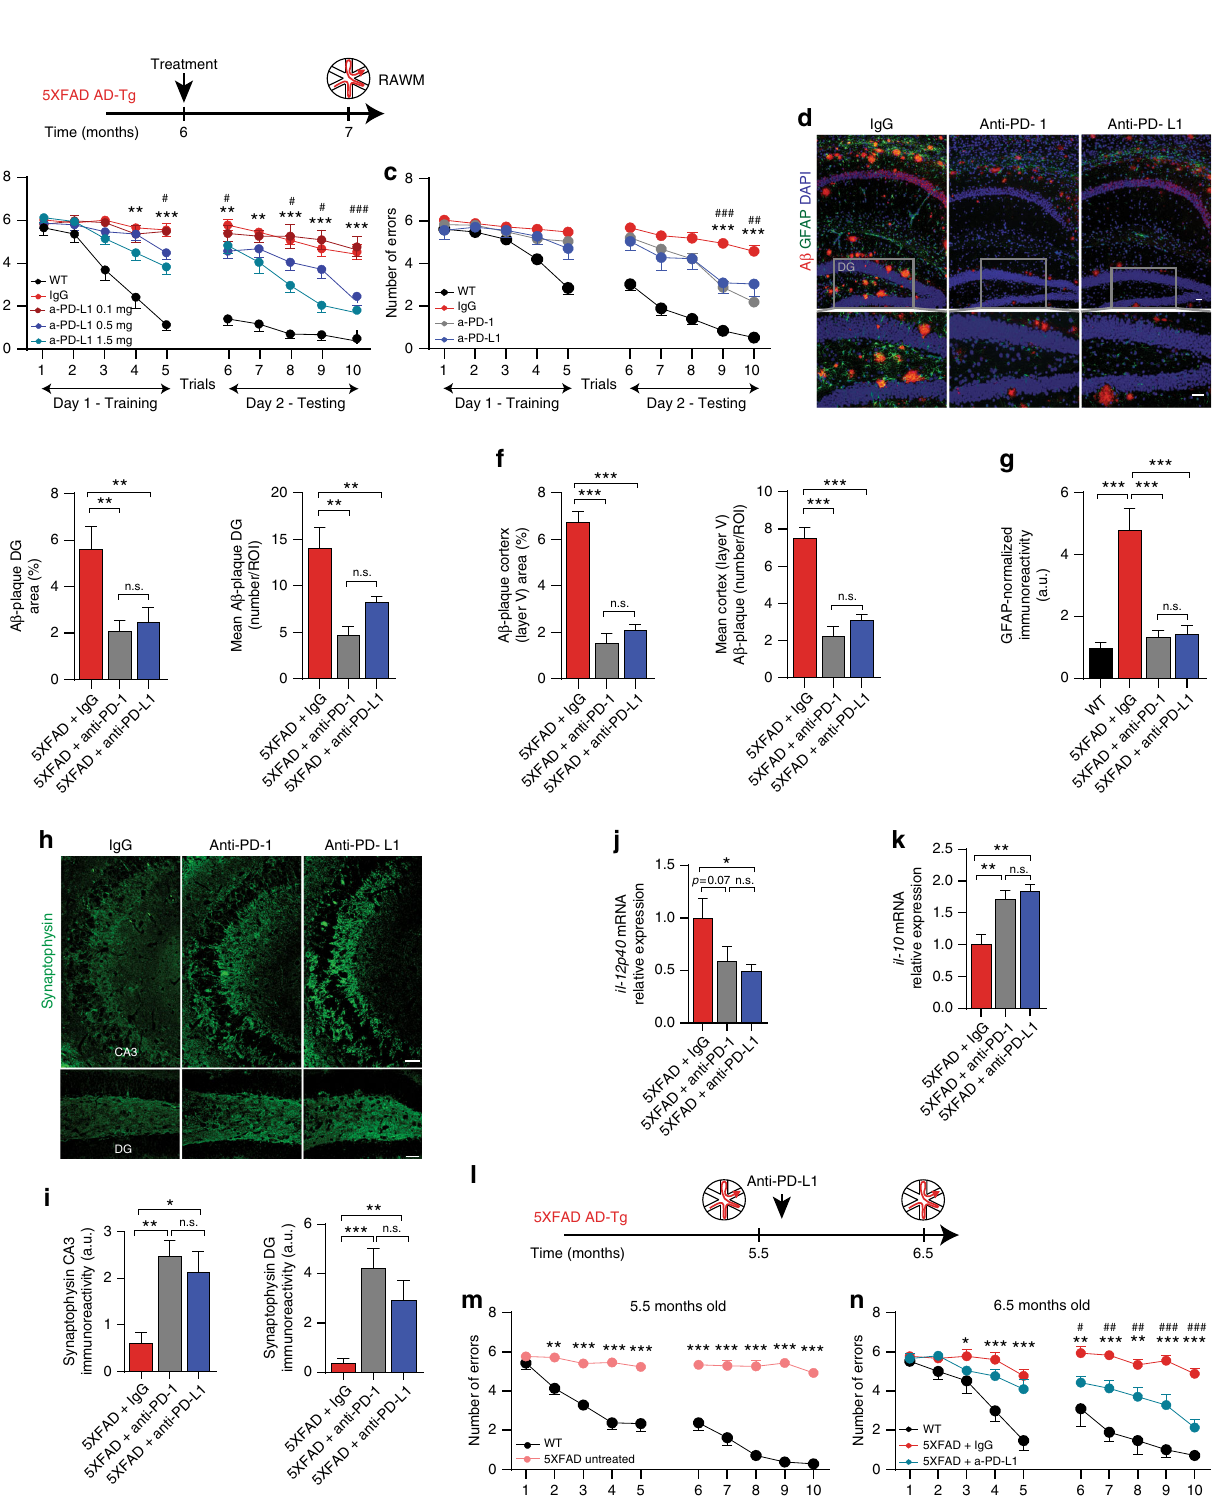
anti-PD-L1 antibody at a dose of 1.5 mg/mouse was slightly more effective than the 0.5 mg dose, but the difference between these two dosages was not signi fi cant (Fig. 3i). Wild-type age-matched mice from the DM-hTAU colony were also tested for the effect of PD-L1 antibody on their cognitive response to the treatment by T-maze; no effect was observed (Supplementary Fig. 6). murine models of dementia 41 – 43 . Therefore, we further